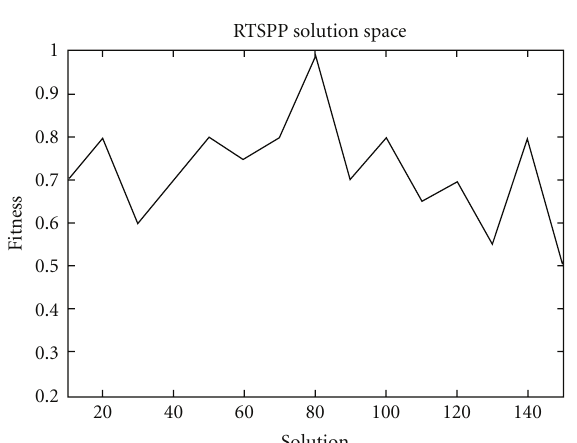
Figure 2: A hypothetical solution space which has been pruned through the use of a heuristic.